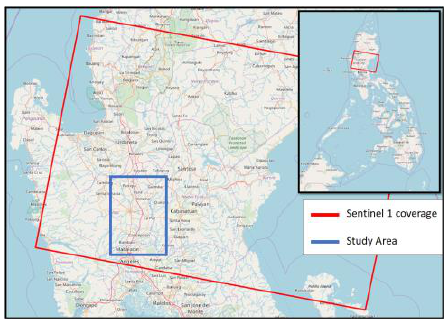
Figure 1. Sentinel 1-A coverage and the study area.